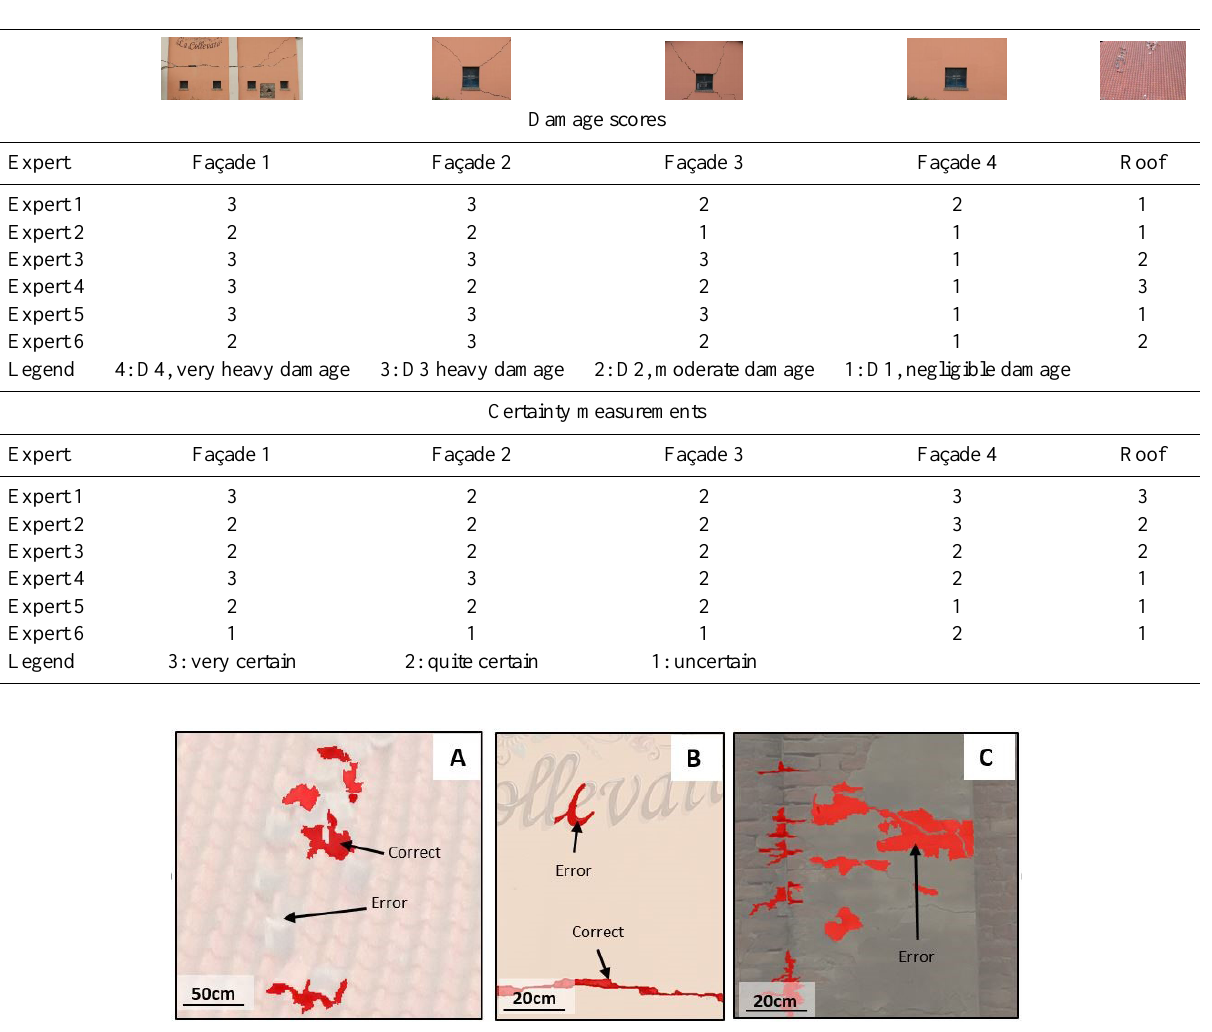
Figure 12. (a) Example of misclassified roof tiles (false negative), (b) example of a letter classified as a crack in a concrete façade (false positive), and (c) example of non-related objects classified as cracks in a brick façade (false positive). Scale